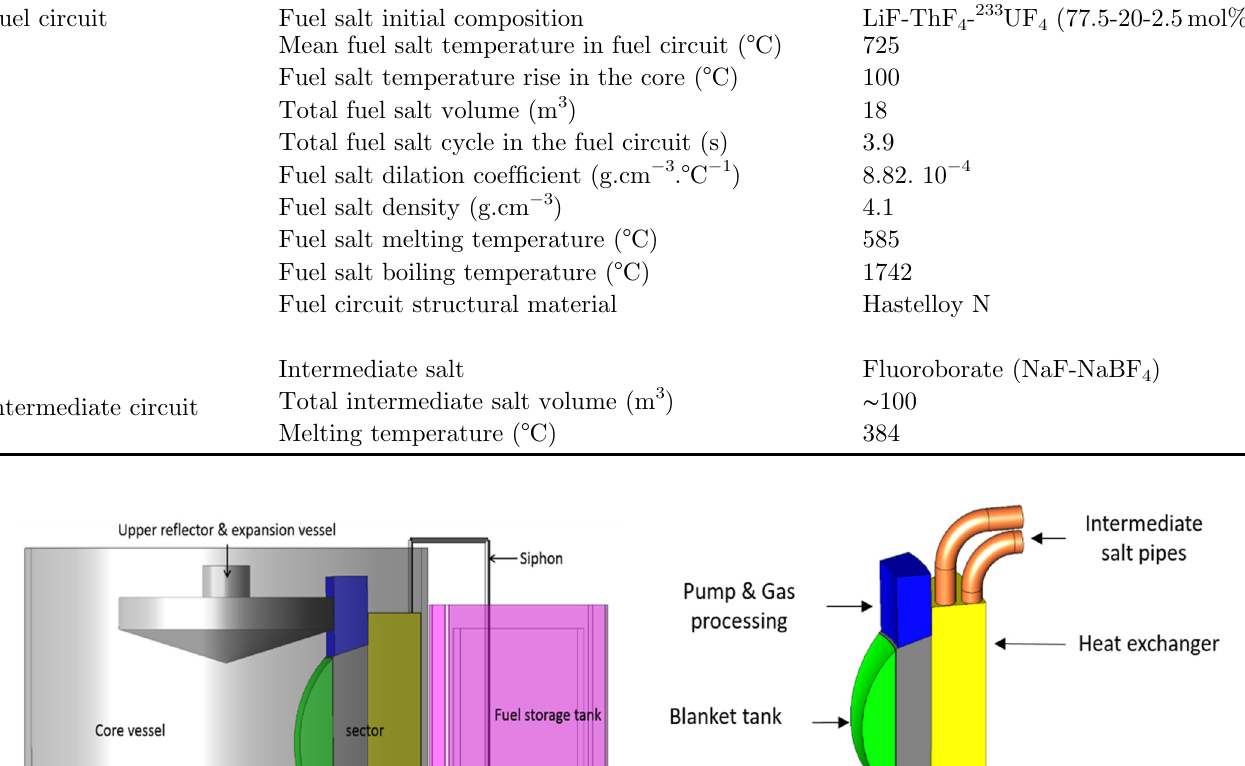
Table 1. Properties of the fuel circuit and intermediate circuit materials [8,9,10,11].